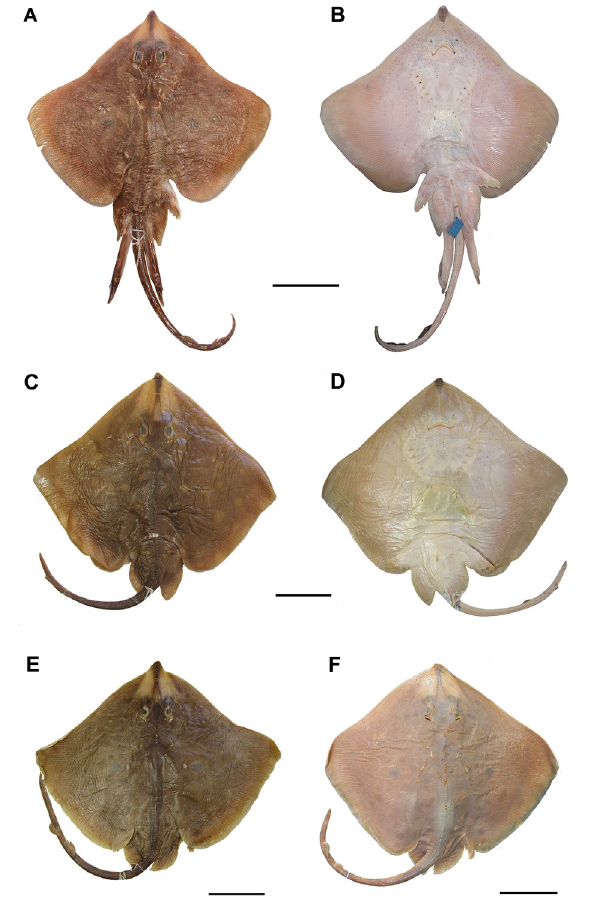
FIGURE 3 | External morphology and color pattern of Rioraja agassizii . A. dorsal view and B. ventral view of MZUSP (uncatalogued), 424 mm TL; C. dorsal view and D. ventral view of UERJ 1569, female, 466 mm TL; E. MZUSP 117280, female, 543 mm TL; F. MNRJ 50512, female, 505 mm TL. Scale bars = 10 cm.